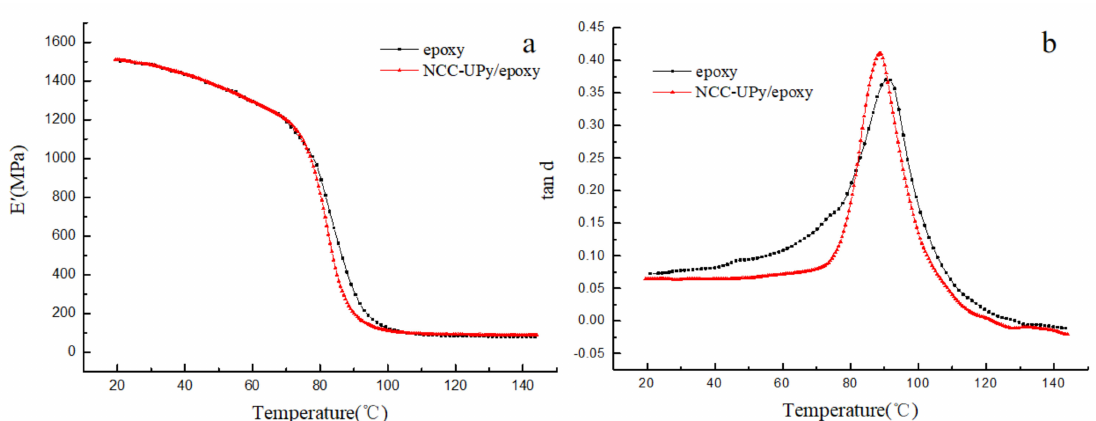
Figure 11. Storage modulus ( a ) and loss factor ( b ) as a function of temperature for epoxy nanocomposites.